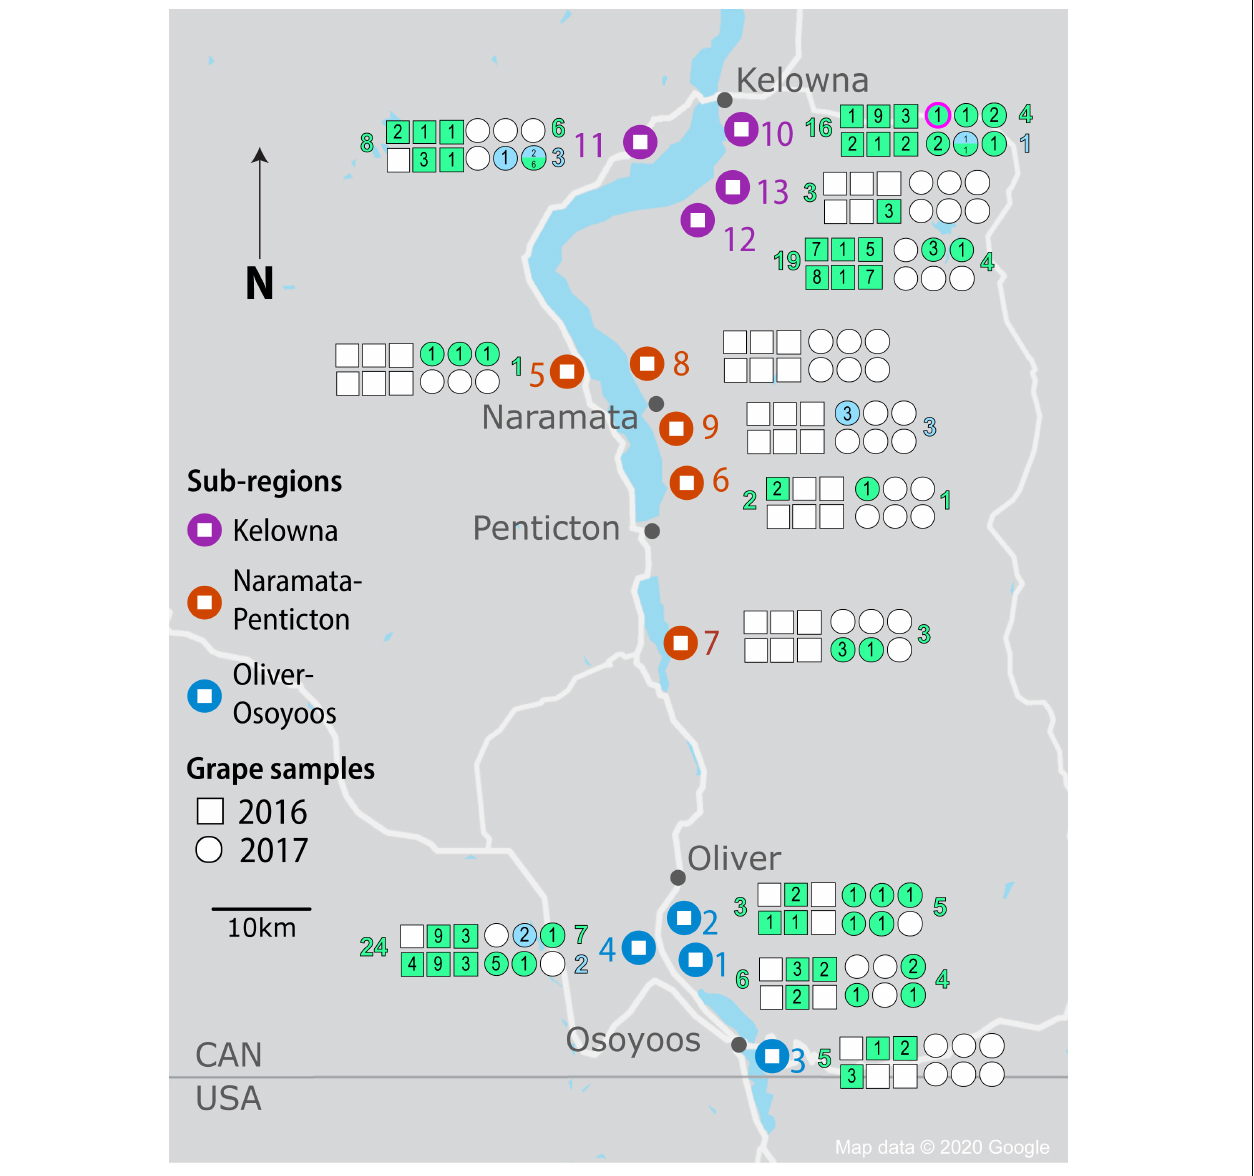
FIGURE 1 | Isolation of Saccharomyces yeasts by sample, vineyard, sub-region and vintage from the OV wine region. Vineyard locations are denoted by large markers and colored by region (KE-purple, NP-orange, and OO-blue). Squares and circles represent each of 6 spontaneous fermentations conducted for each vineyard in 2016 and 2017, respectively. Shaded squares and circles indicate fermentations that reached two-thirds sugar depletion; green shading indicates Saccharomyces cerevisiae strains while blue shading indicates Saccharomyces uvarum strains. The number of strains isolated from a spontaneous fermentation is noted within each square or circle. The number of S. cerevisiae and S. uvarum strains isolated in total from each vineyard are listed in green and blue, respectively (to the left of the vineyard for 2016 fermentations and to the right of the vineyard for 2017 fermentations). The circle outlined in fuschia for vineyard #10 denotes the fermentation from which S. paradoxus was